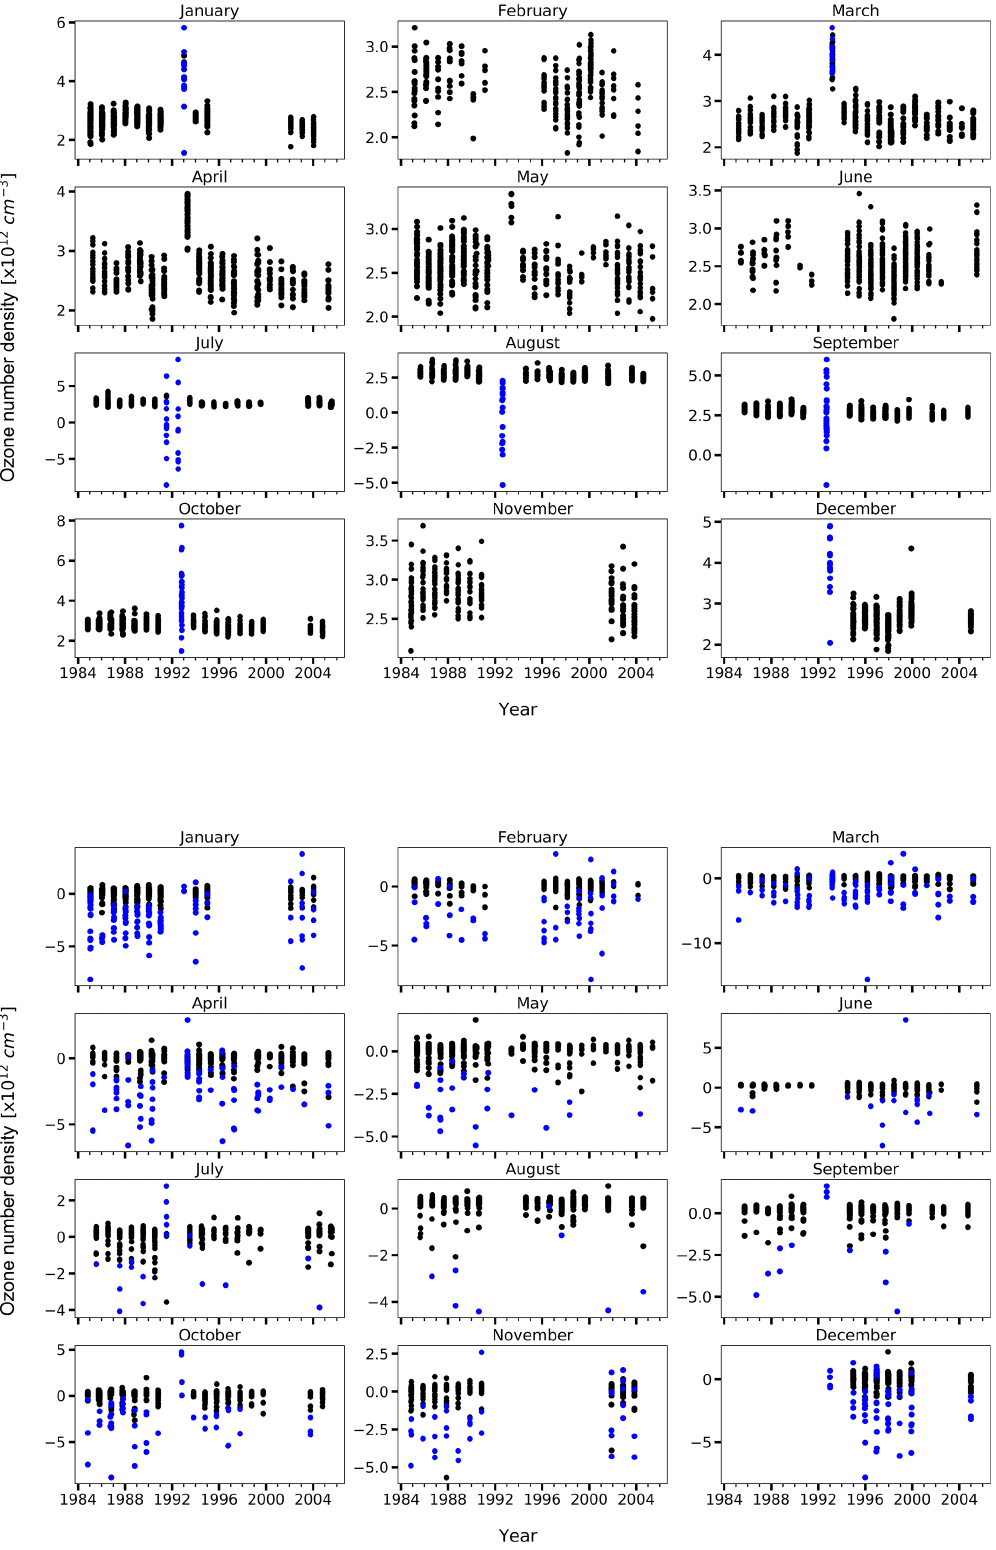
Figure 8. Remaining SAGE II ozone at 21km (top) and 16km (bottom) between 5 ◦ and 15 ◦ S for each month of all years (black) after the LOS optical depth rule has been applied to the ozone data set (blue